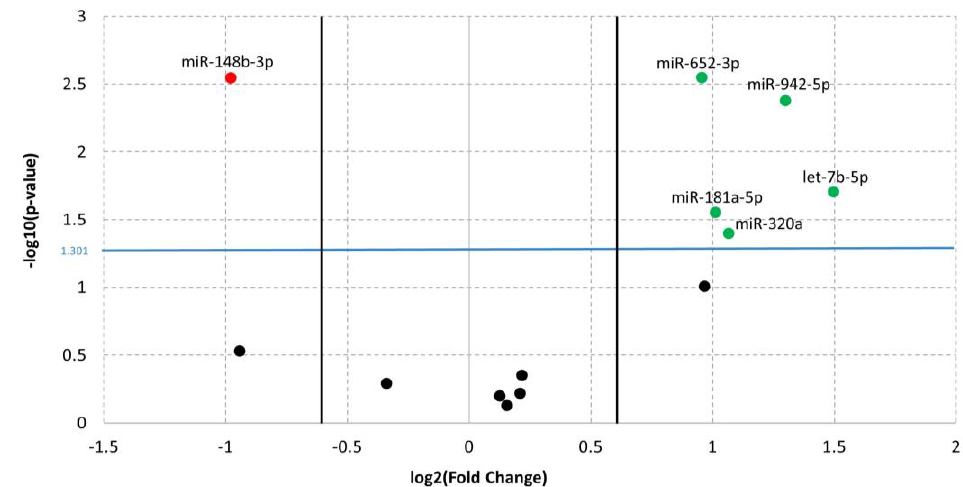
Figure 2. Volcano plot of qPCR data referring to the comparison of miRNAs expressions between ADHD and TDs. The Y-axis values show the negative logarithm base 10 (log10) of the p-values; the blue horizontal line on the plot represents the threshold p-value used for this analysis (0.05). The values in the X-axis indicate the log 2 differences in estimated relative expression of the miRNAs of interest; the vertical lines represent the thresholds for the log 2 fold change (equivalent to a fold change of 1.5). Thus, the red dot corresponds to downregulated miRNA, whereas the green dots correspond to upregulated miRNAs.